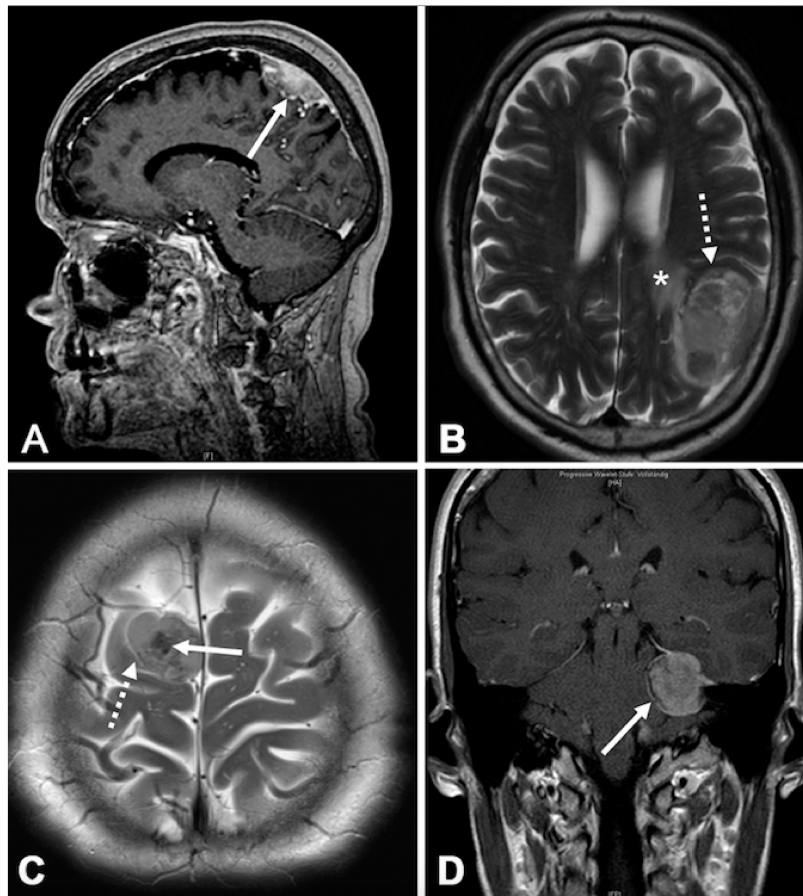
Figure 4. Illustrative samples of the analyzed characteristics on magnetic resonance imaging. Sagittal T1-weighted imaging shows an irregular, lobulated tumor shape ( A , arrow) and a heterogeneous contrast-enhancement of the tumor. Axial T2-weighted MRI illustrates the loss of integrity of the arachnoid layer ( B , dashed arrow), a regular round tumor shape, and a mild peritumor brain edema (*). The lesion is hyperintense as compared to the brain tissue. Axial T2-weighted MRI shows intratumor calcifications ( C , arrow) and a clear cerebrospinal fluid cleft at the brain / tumor surface ( C , dashed arrow), indicating an integer arachnoid layer. Figure d depicts capsular ( D , arrow) and homogenous contrast-enhancement on coronal T1-weighted